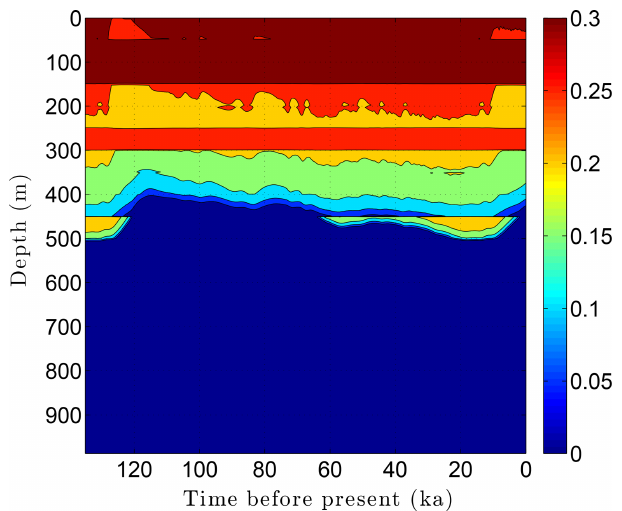
Figure 12. Bulk thermal conductivity k variations over the last ice- age cycle within the example sedimentary sequence (Fig.